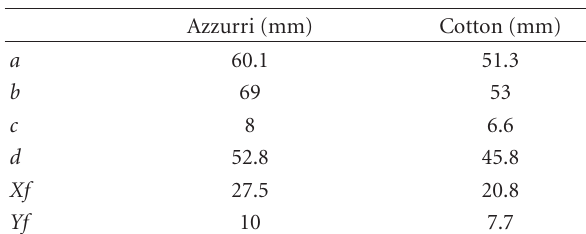
Table 2: Patch dimensions of the tip-truncated ETMPA on the Azzurri and cotton substrates, used as antenna elements in the array